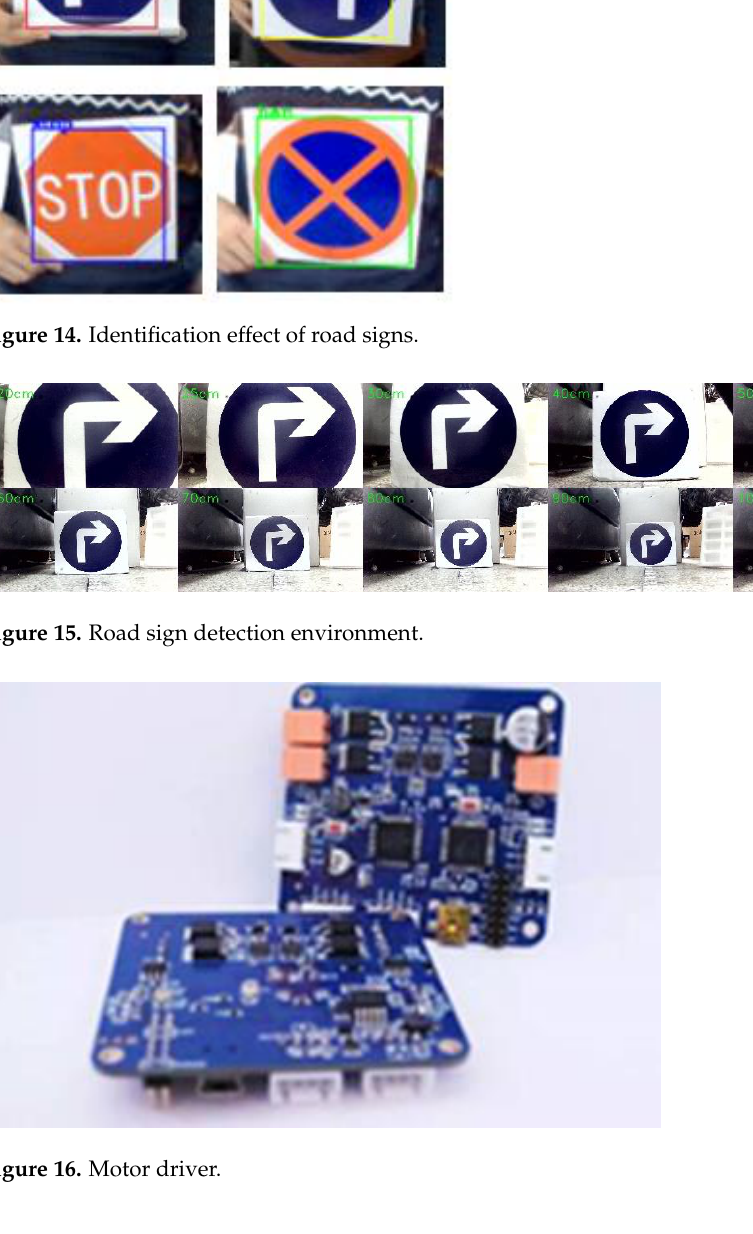
Figure 17. Motor speed curve. Figure 18 shows the artificially constructed experimental environment, including the environment of obstacles and road signs. The obstacle avoidance experiment of the phys- ical prototype was conducted in the constructed experimental environment, and the ex- perimental results are shown in Figure 19 The experimental results show that this method can successfully identify road signs and realize autonomous obstacle avoidance in com- plex environments. Figure 20 shows the real-time picture of road sign detection (not the experimental environment as shown in Figure 19).